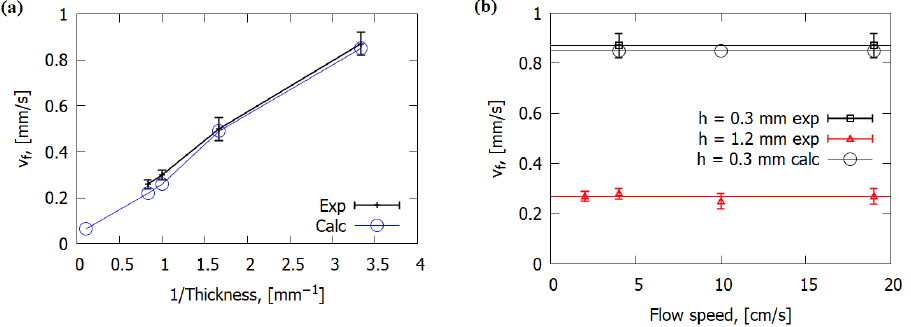
Figure 7. Dependence of the ROS over GFRER slabs on the slab thickness ( a ) and on the gas flow rate ( b ) at 25% O 2 .